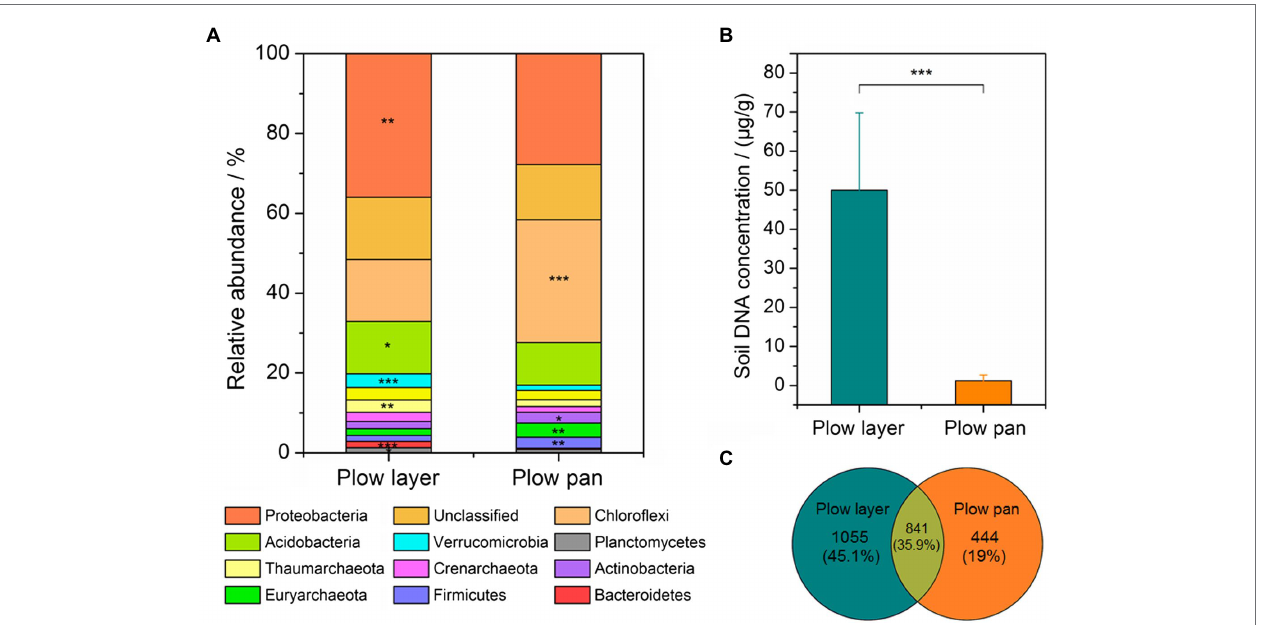
FIGURE 2 | Comparison of the bacterial community composition and microbial mass in the plow layer and plow pan soils. (A) Dominant microbes at the phylum level. (B) Variations in the soil DNA concentrations. (C) Variations in the OTU numbers. Asterisks indicate the significant difference (paired-sample t -test, * p < 0.05, ** p < 0.01, and *** p <